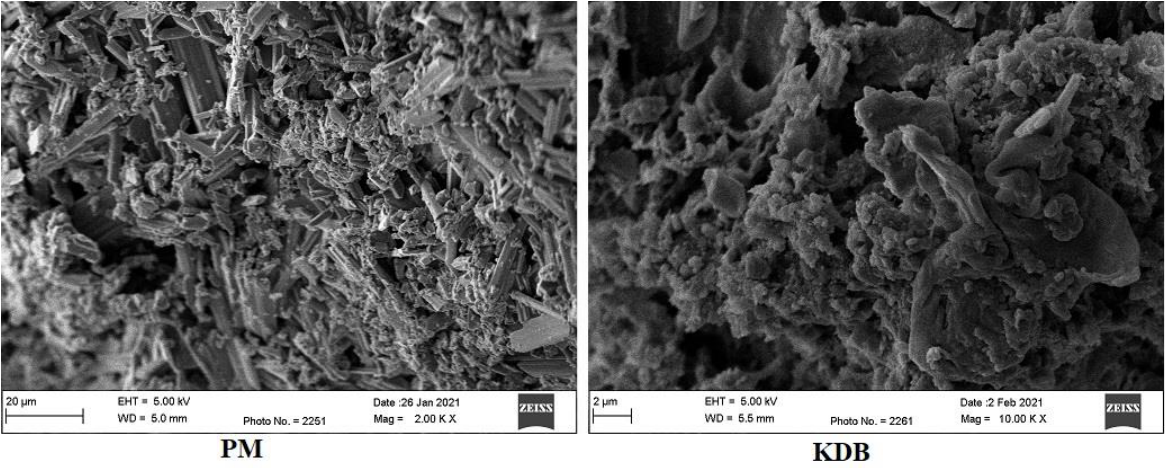
Figure 7. SEM images of the physical mixture (PM) and the optimized kneaded ternary complex (KDB).